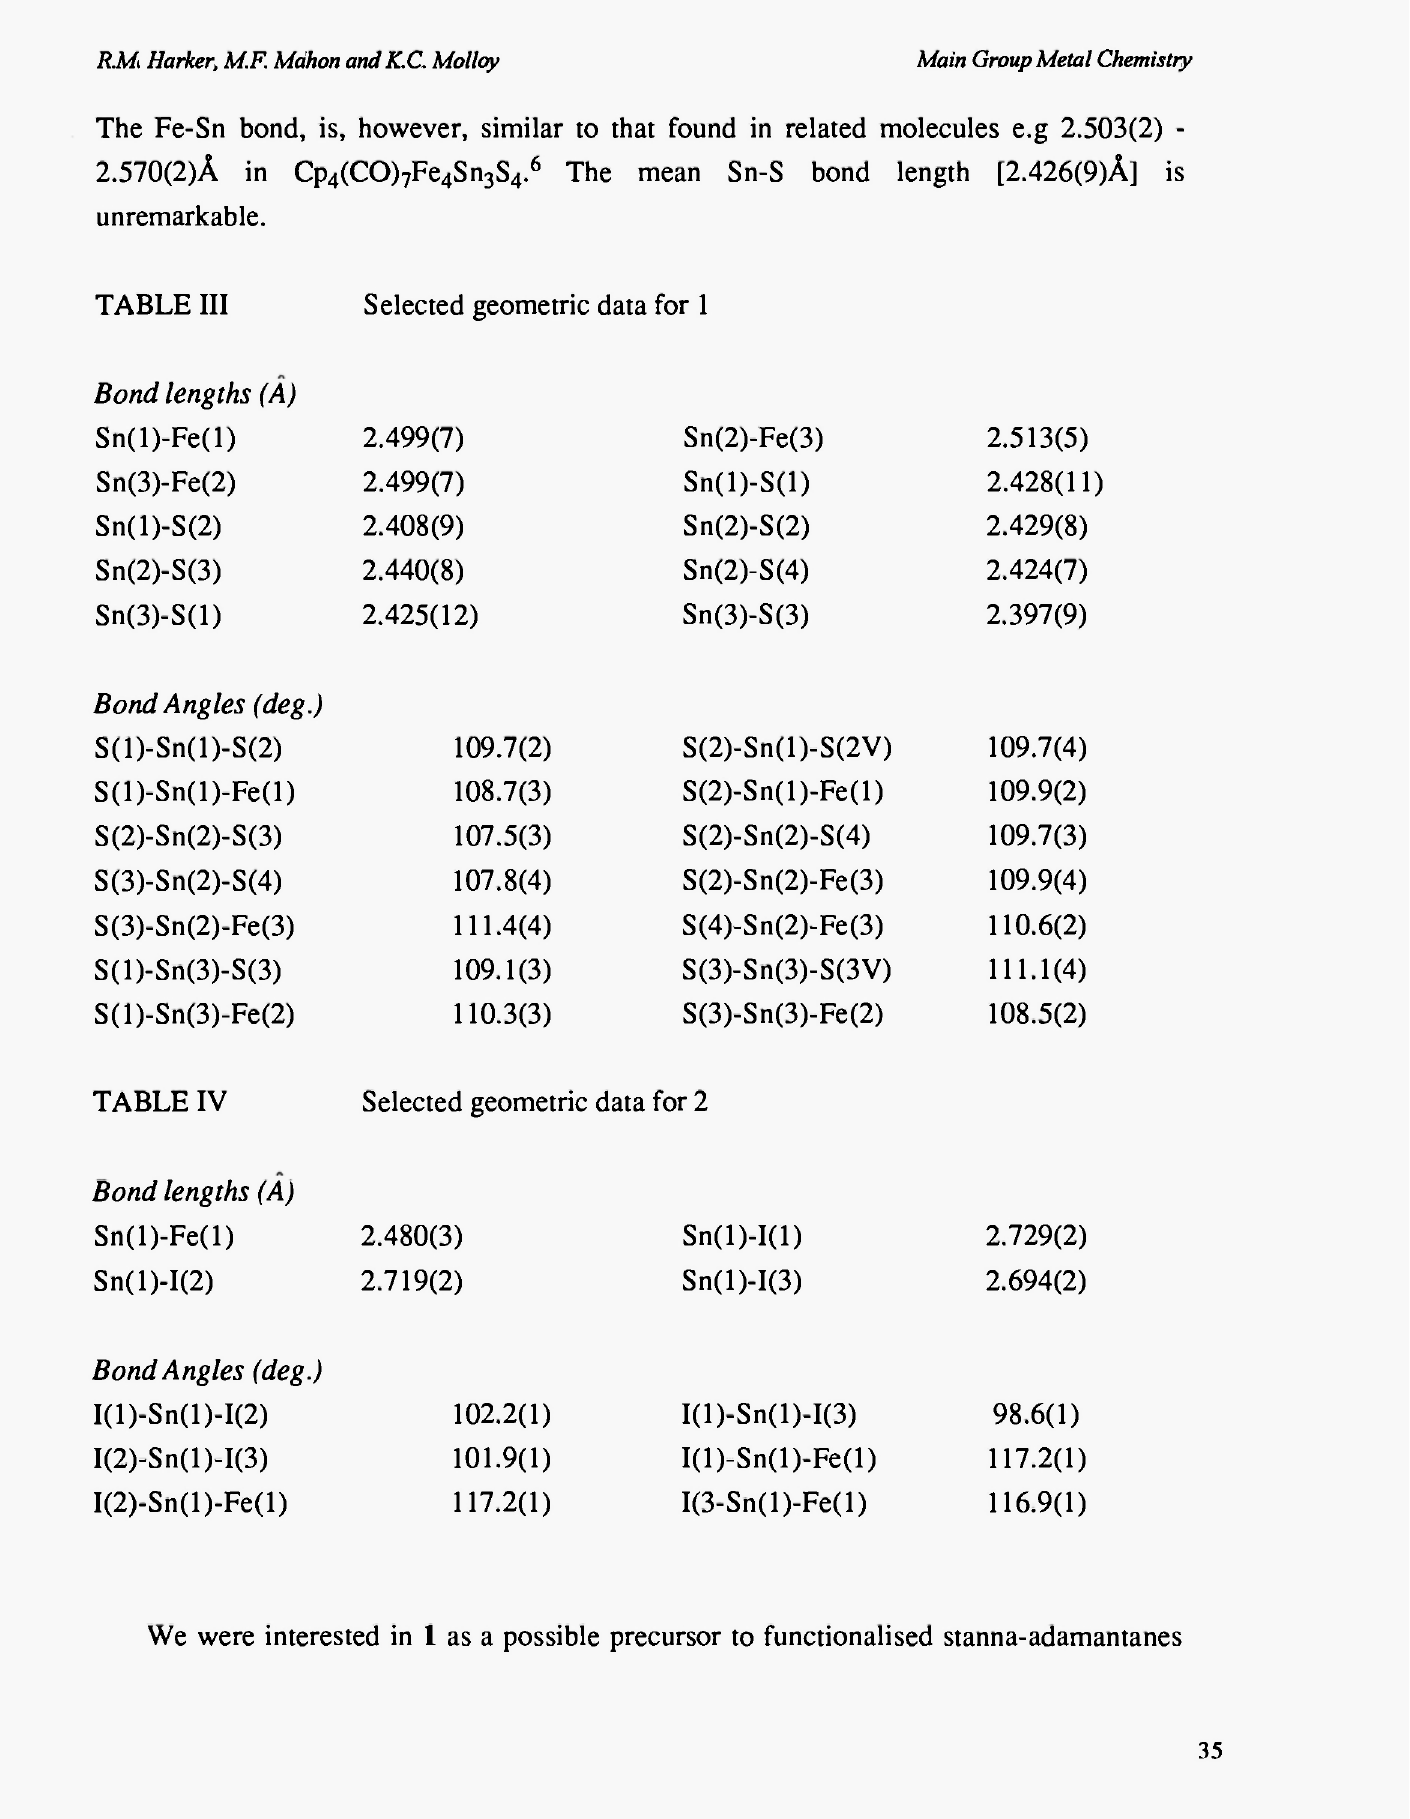
Selected geometric data for 1 Bond lengths (A)